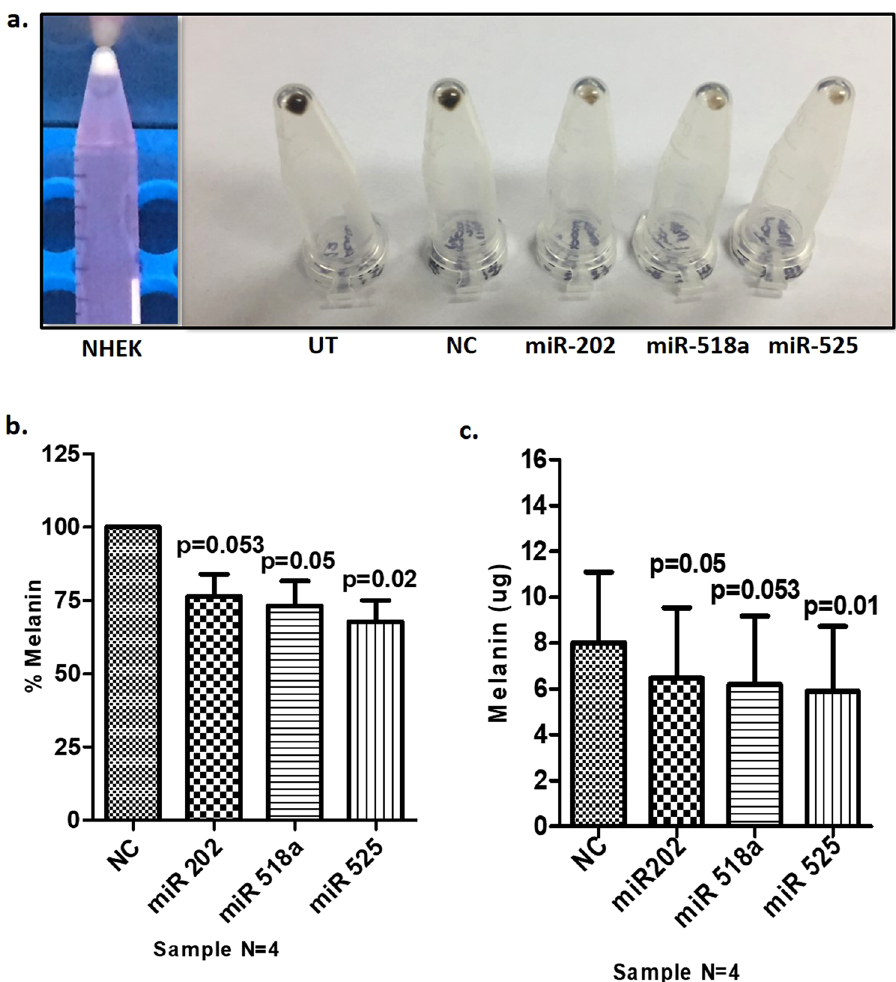
Figure 6. Melanosome transfer from melanocytes to keratinocytes after transfection of keratinocytes with selected pre-miRs. ( a ) Representative image for pellet color in pure Keratinocyte culture (NHEK, with no pigment) and keratinocytes transfected with miRNAs, co-cultured with melanocytes and differentially trypsinized to get only pure keratinocytes. Pellet color is lighter in transfected Keratinocytes co-cultured with Melanocytes as compared to scrambled control (NC). UT is Untransfected control. ( b ) Bar graph showing percentage decrease in Melanin content in keratinocytes that were transfected with, pre-miR-202,